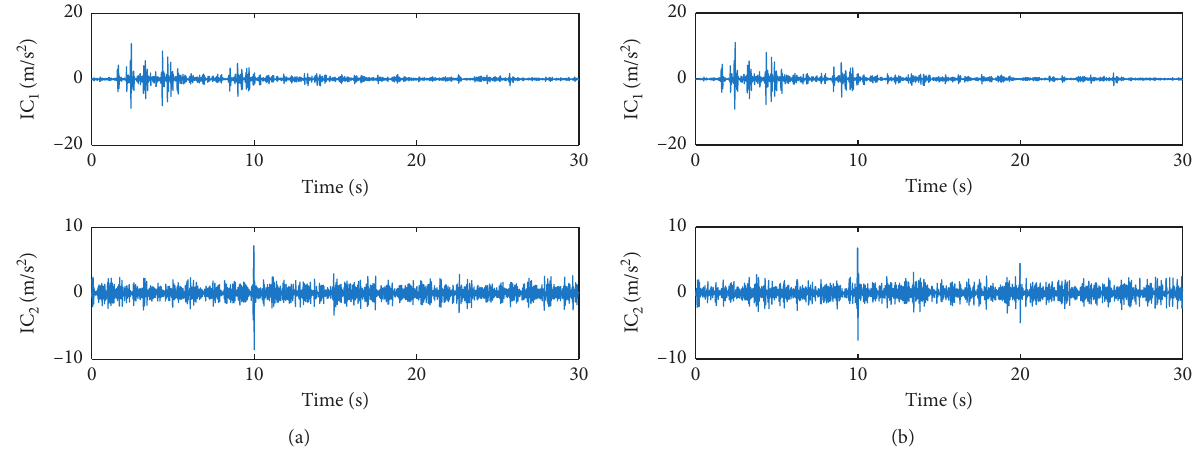
Figure 14: Independent component of the simulated structure under El-Centro earthquake wave. (a) Case 1. (b) Case 2.